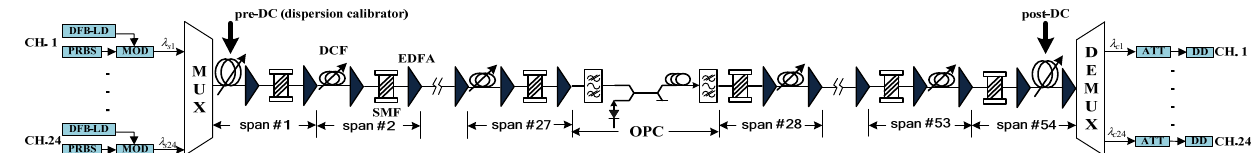
Figure 1. The 960 Gb/s WDM transmission system through the dispersion-managed link and the midway OPC.